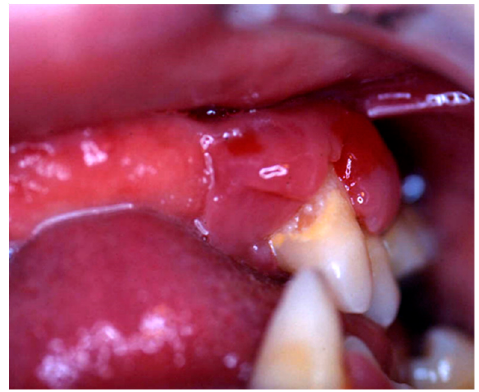
Figure 1. Hyperplastic, reddish and inflamed gingiva unresponsive to conventional medical and instrumental periodontal treatments; such findings, along with the lack of multiple teeth, should arouse the suspicion of LCH in children.